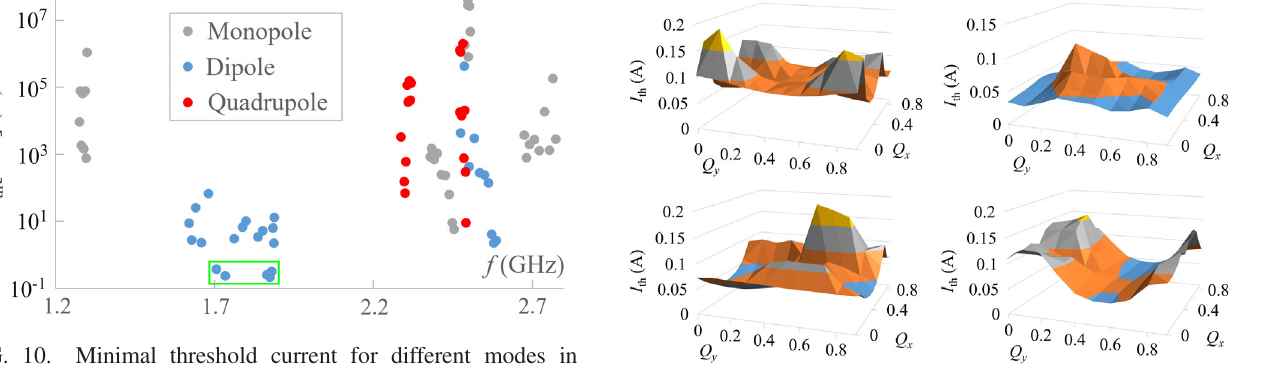
FIG. 12. Examples of 2D phase trombone scans for different configurations of MESA ( Q x;y ¼ ϕ x;y = 2 π ).